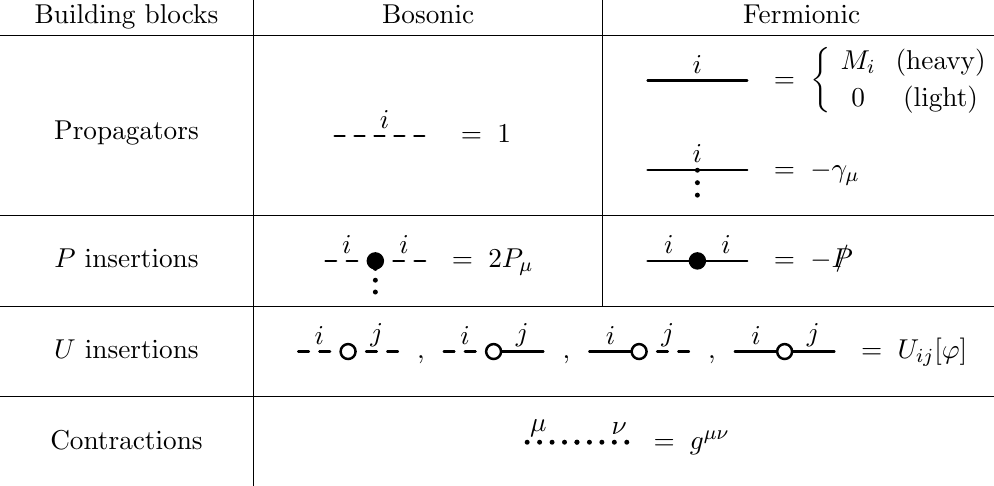
Table 1 . Building blocks of covariant diagrams needed in this paper. i; j represent (cid:12)elds that can be either heavy or light unless speci(cid:12)ed otherwise. A covariant diagram must contain at least one heavy propagator so that its prefactor (2.22) is nonzero. See [22] for a detailed derivation of the rules for covariant diagrams from evaluating the CDE series of eq.